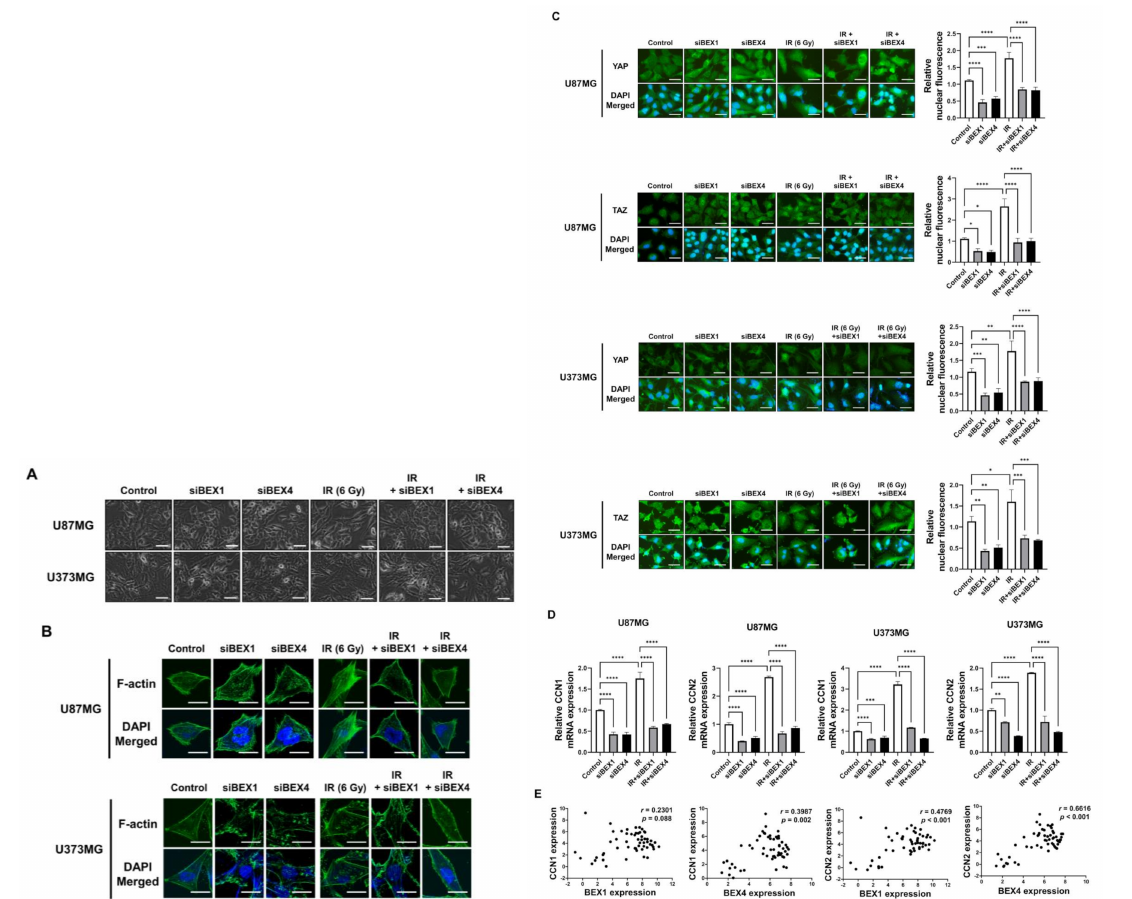
Figure 3. BEX1 and BEX4 modulate GBM progression through regulation of mechanotransduction. ( A ) The morphological changes in U87MG after knockdown of BEX1 or BEX4 with/without irradiation were photographed. ( B ) The formation of F-actin in U87MG after knockdown of BEX1 or BEX4 with/without irradiation was visualized by phalloidin staining assay. F-actin was stained green and nucleus was stained blue. ( C ) The alteration of subcellular localization of YAP or TAZ in U87MG after knockdown of BEX1 or BEX4 with/without irradiation was visualized by IF. YAP or TAZ was stained green and nucleus was stained blue. The nuclear localization of YAP or TAZ was quantified by ImageJ ( n = 8). ( D ) The mRNA expression levels of CCN1 and CCN2 in U87MG after knockdown of BEX1 or BEX4 with/without irradiation were assessed by qRT-PCR. ( E ) Pearson’s correlation plots indicating gene expression levels of BEX1 , BEX4 , CCN1 , and CCN2 in proneural GBM patients from the CGGA database. Pearson’s correlation coefficient (r) and p -values are shown for each analysis. Statistical analysis was performed with one-way ANOVA plus a Tukey’s multiple comparisons test for ( C , D ). * p < 0.05, ** p < 0.01, *** p < 0.001, **** p <